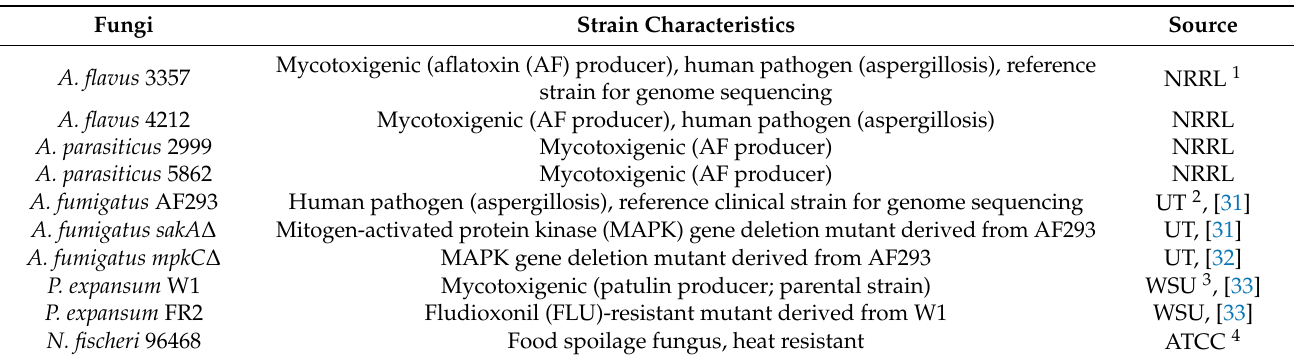
Table 1. Characteristics of fungi used in this